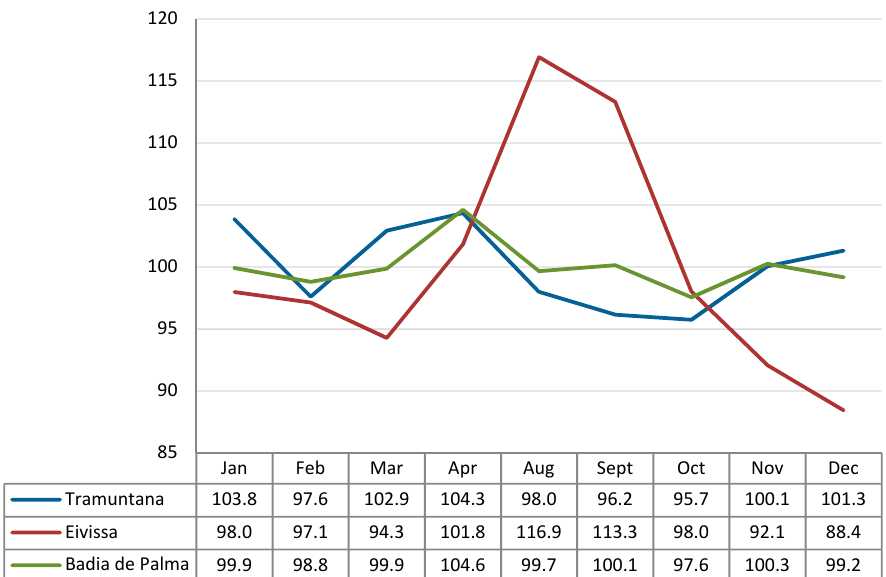
Figure 8. Total monthly emitted light (>2 nW/cm 2 /sr). Monthly means 2012–2017. Serra de Tramuntana, Eivissa, and Badia de Palma. In indexed numbers (annual mean for each territory = 100).